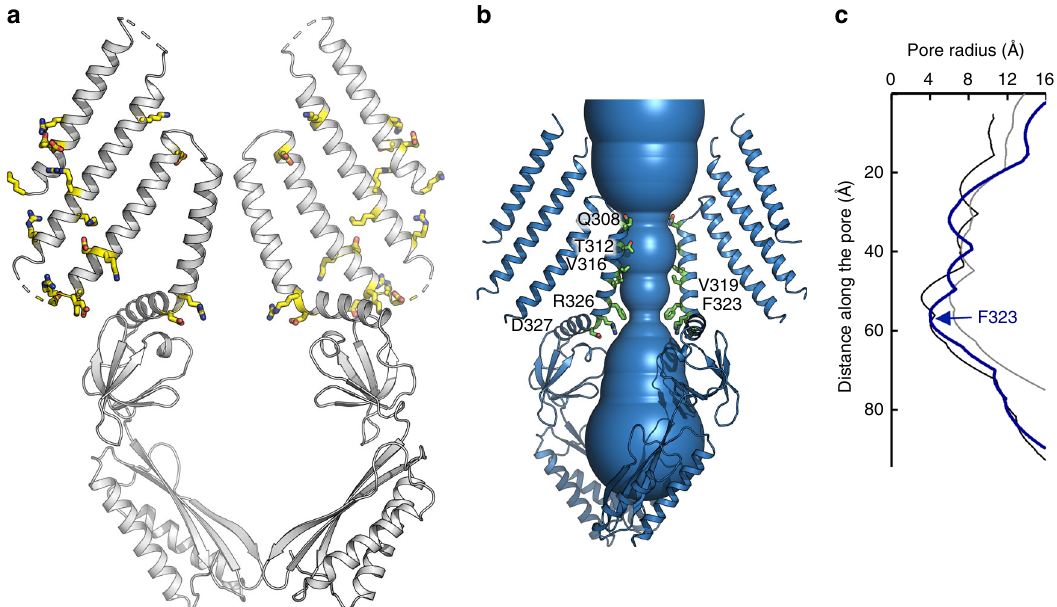
Fig. 2 The closed conformation of At MSL1. a Distribution of charged residues, shown in stick representation, in the transmembrane helices indicates a curved transmembrane region. Only two opposing MSL1 subunits are shown for clarity. b The pore structure. Residues lining the pore are highlighted in stick representation. c The pore pro fi le of MSL1 (blue). Also shown are the pore pro fi les of the closed (black, PDB: 6RLD) and open (gray, PDB: 2VV5) Ec MscS structures.